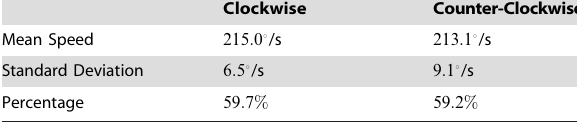
Table 3. Speed of movement of the head direction cell activity packet during testing in the absence of visual input with a distribution of axonal conduction